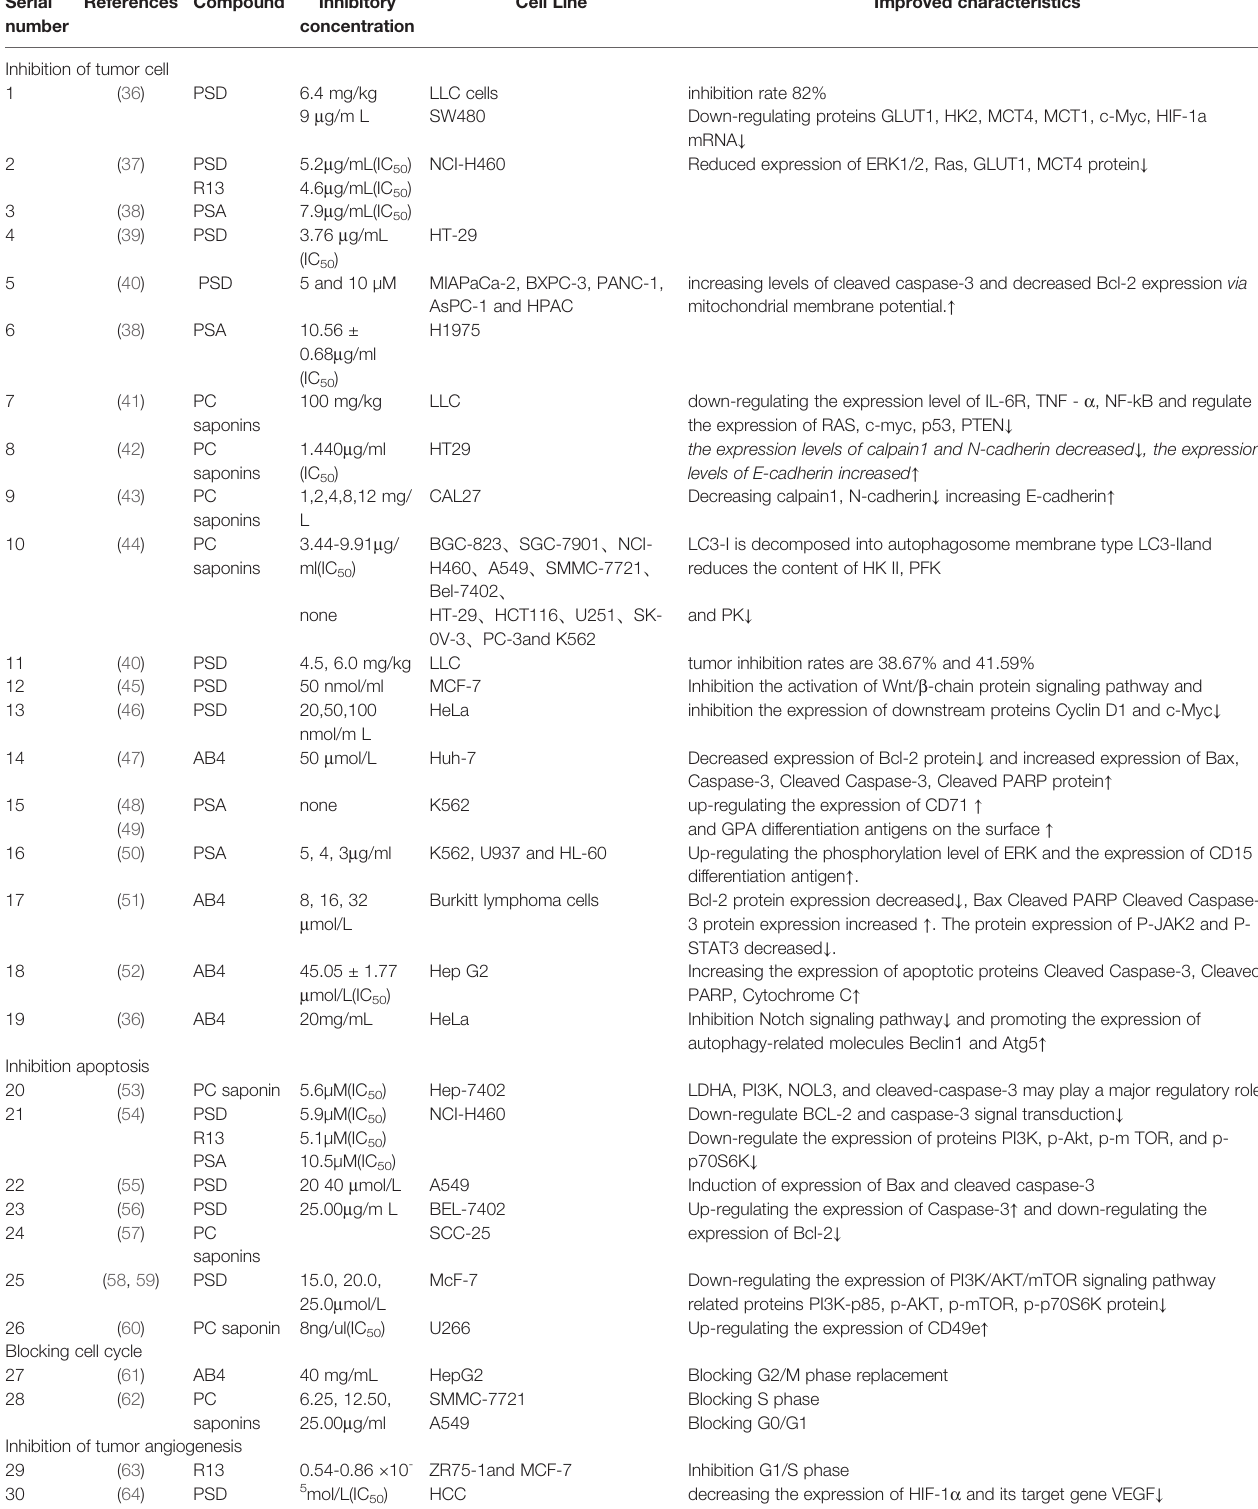
TABLE 2 | The studies of Pulsatilla chinensis (Bge.) Regel. on different cancer cell lines and normal cell lines. Serial References number